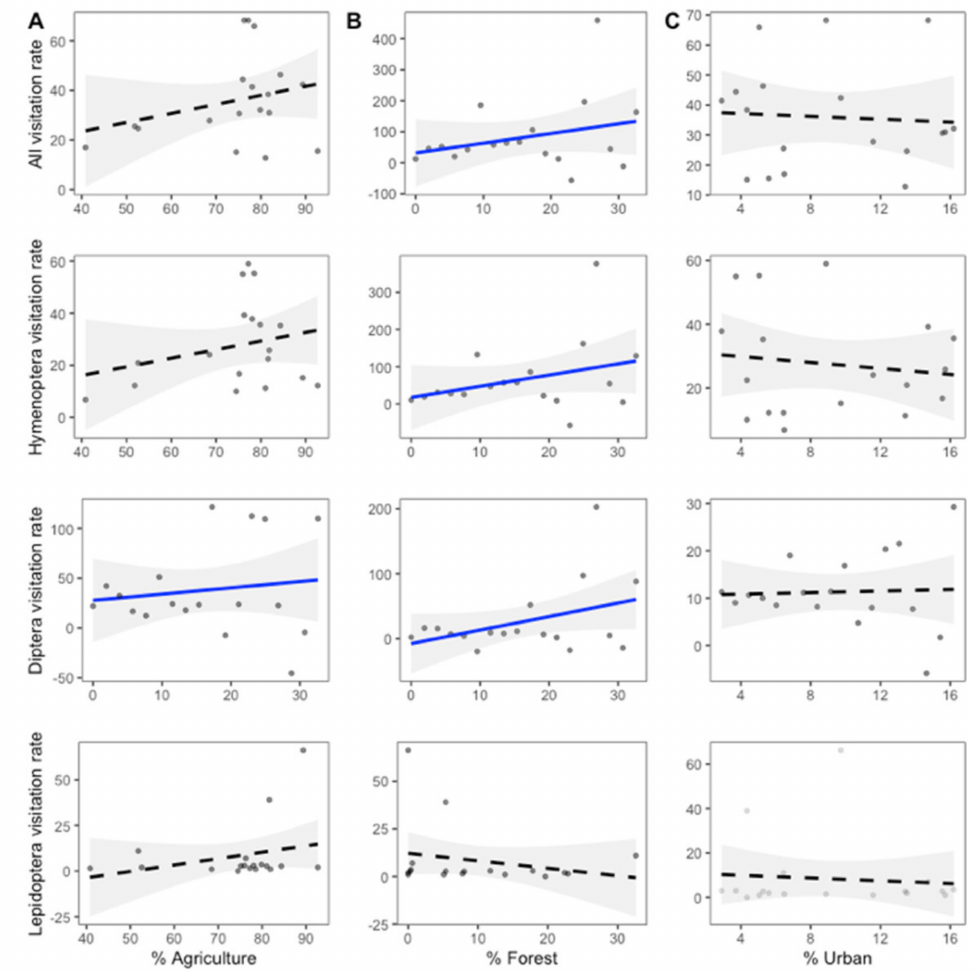
Figure 5. Visitation rates in relation to the percentage of ( A ) agriculture, ( B ) forest, and ( C ) urban landscape within a 3 km radius from each study site. All regressions are plotted with 95% corre- sponding confidented intervals (scales have been optimized for each set of analysis and therefore vary between plots). Solid blue lines indicate significant associations ( p < 0.05), whereas dashed lines indicate a non-significant relationship ( p > 0.05). For statistics, see Supplementary Material Table